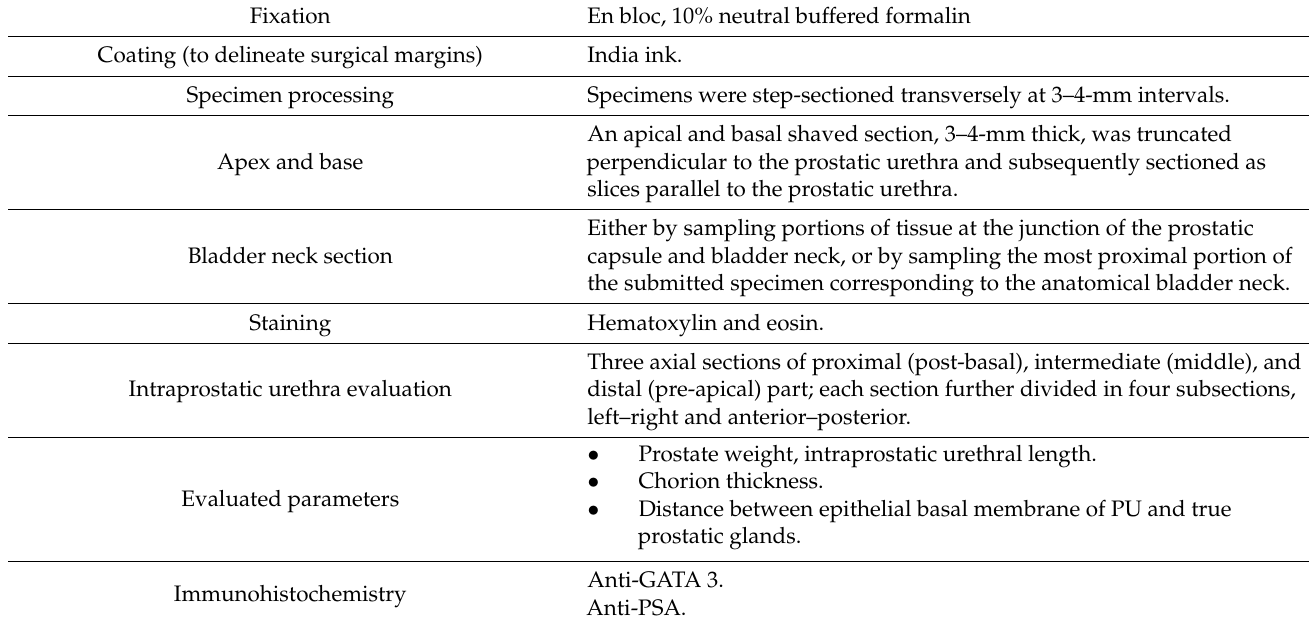
Table 1. Pathologic evaluation of the